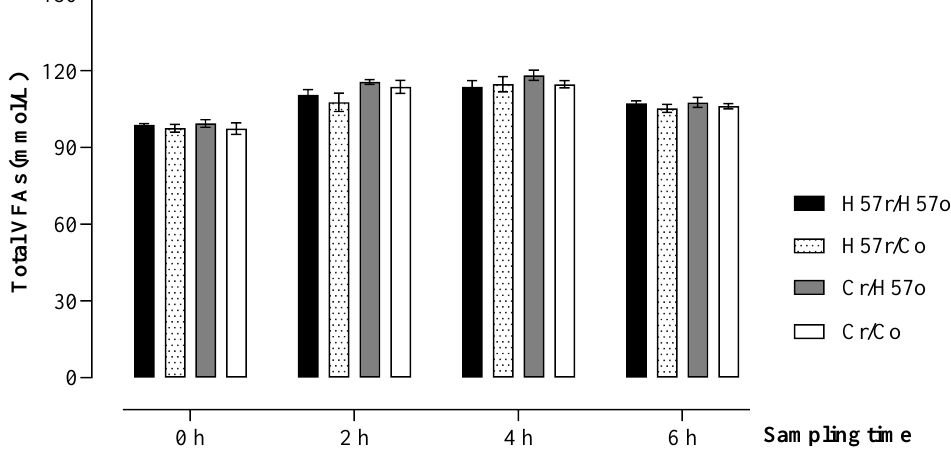
Figure 4. Change in ruminal volatile fatty acid (VFA) concentrations following the short-term addition of H57 or control pellets into the digestive system, either orally (o) or through a rumen fistula (r). Error bars represent s.e.m.